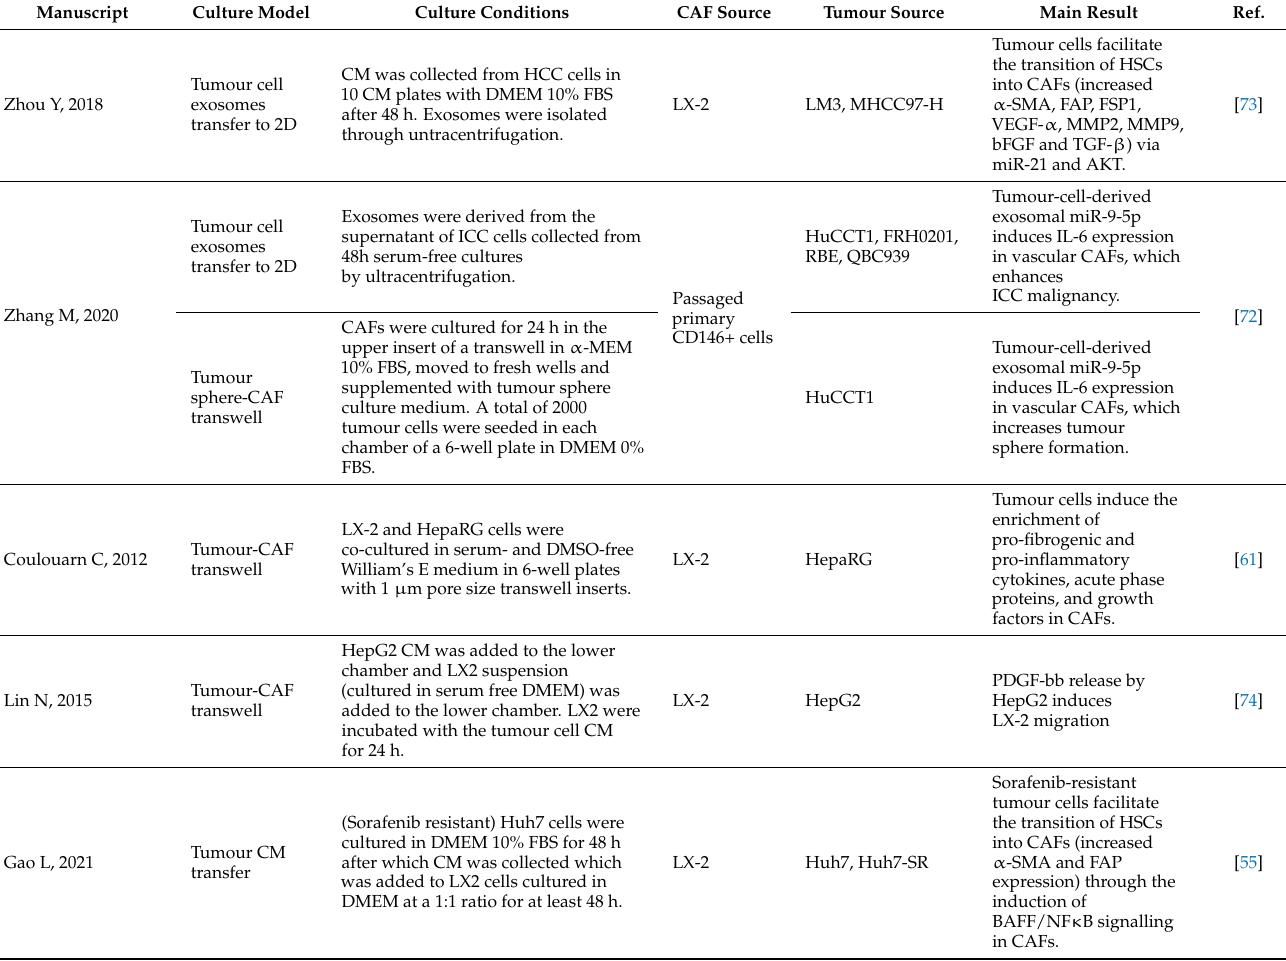
Table 2. Overview of studies on CAF-tumour interaction for primary liver